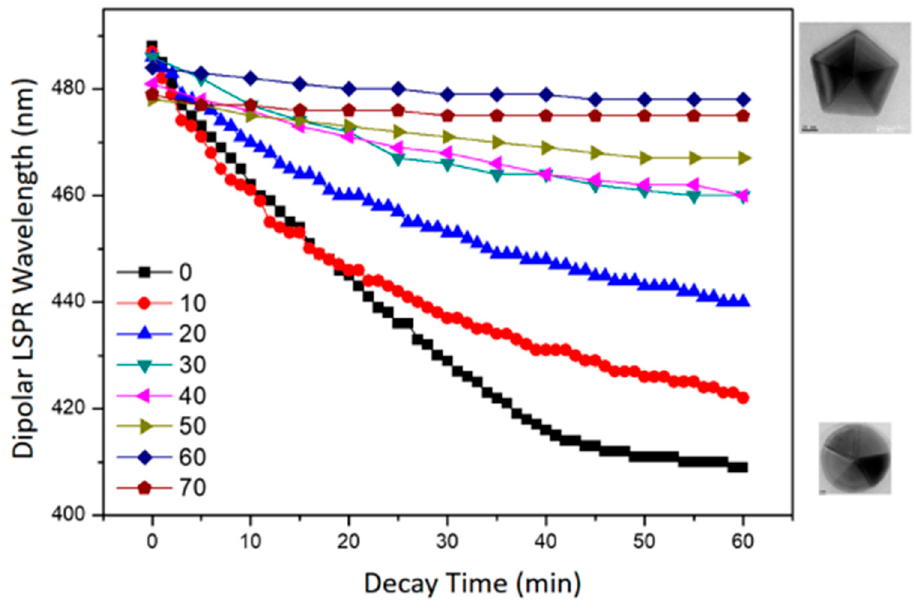
Figure 9. Time-dependent longitudinal dipolar LSPR wavelength of D-AgNPs after the reconstruction processes at different bath temperatures.